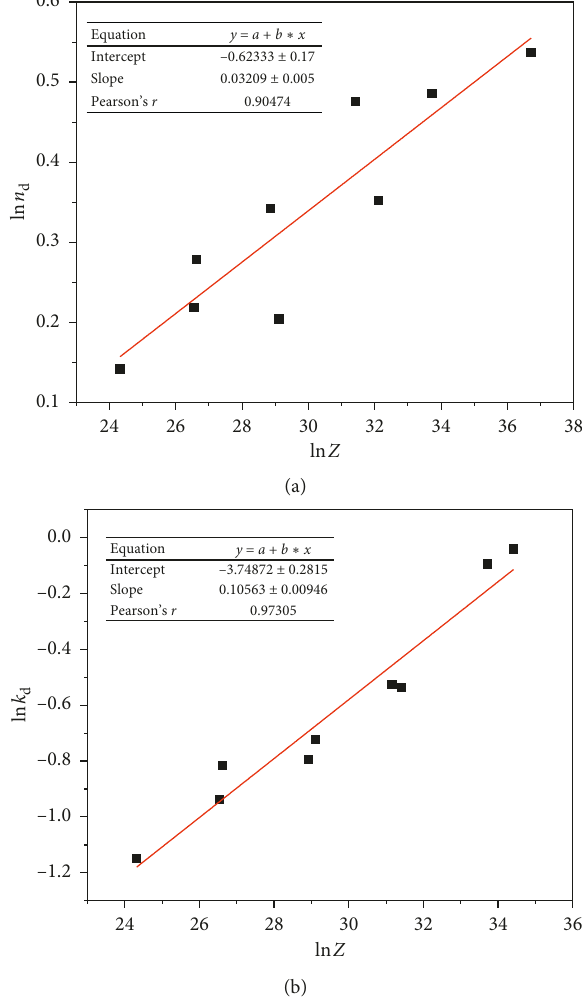
and ln Z and (b) ln k d